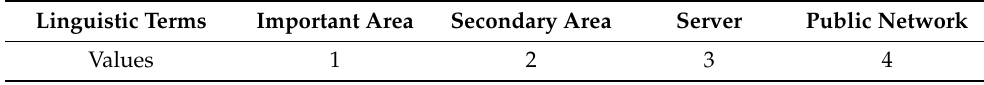
Table 3. Reference values of the area.